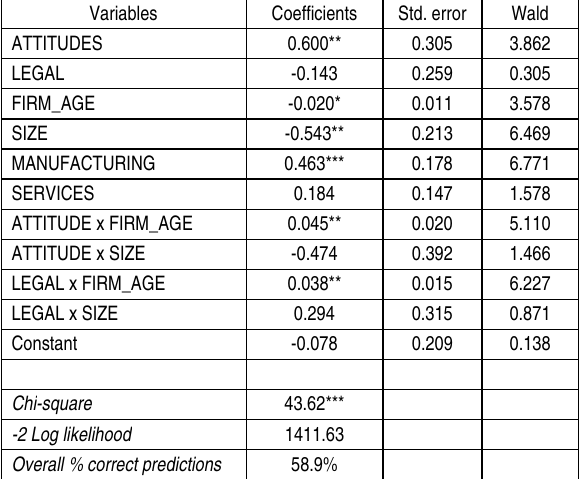
Table 2. Results from a binary logistic regression (dependent variable =